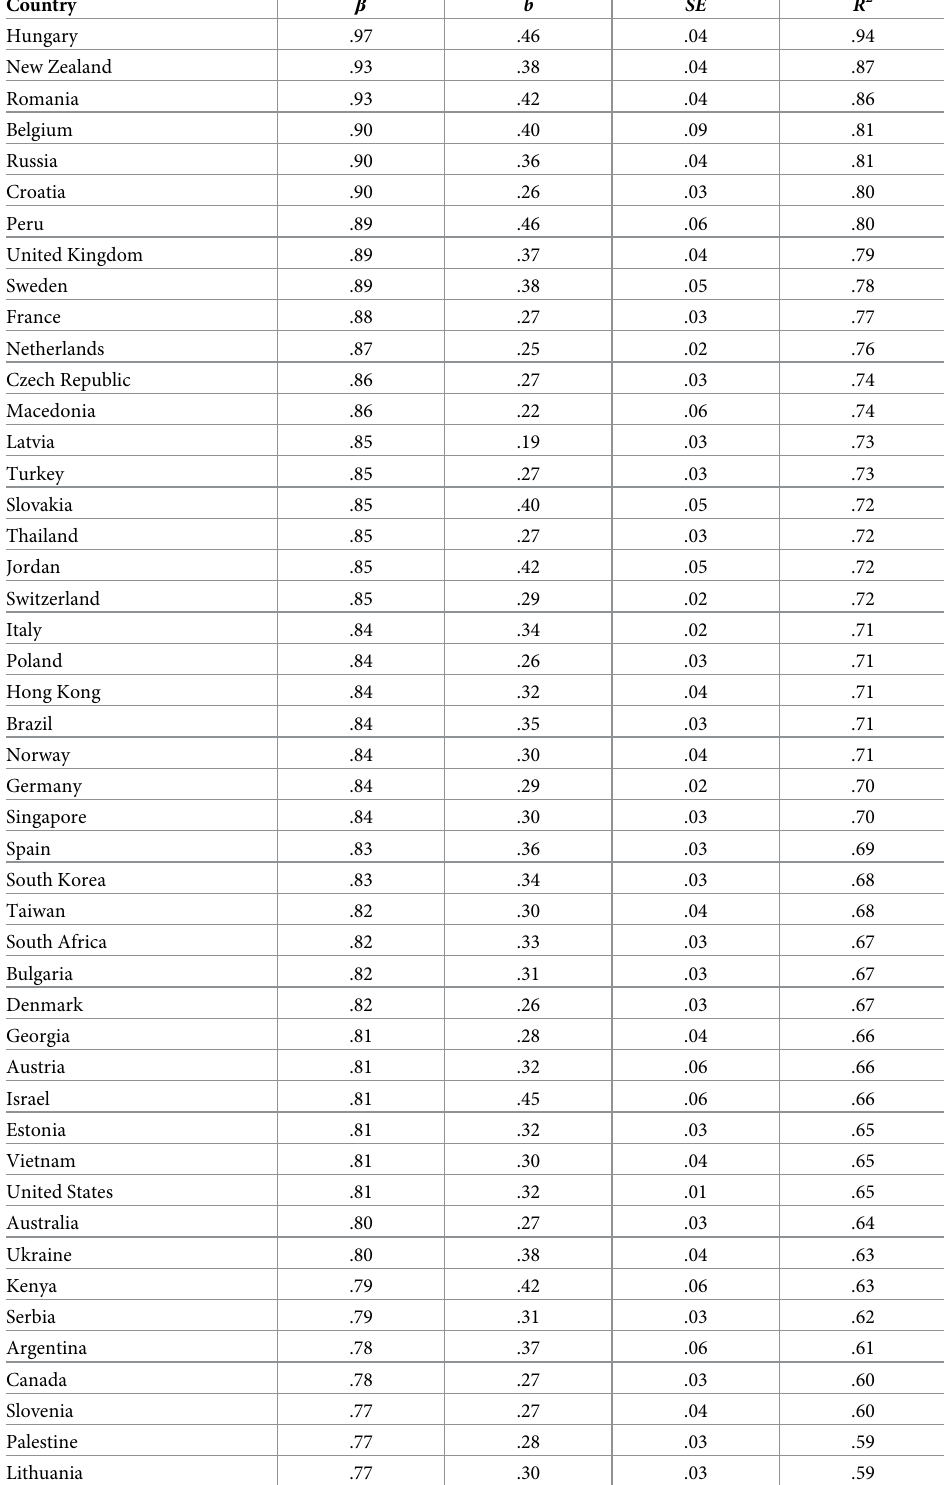
Table 7. Results from structural equation model with IHS ~